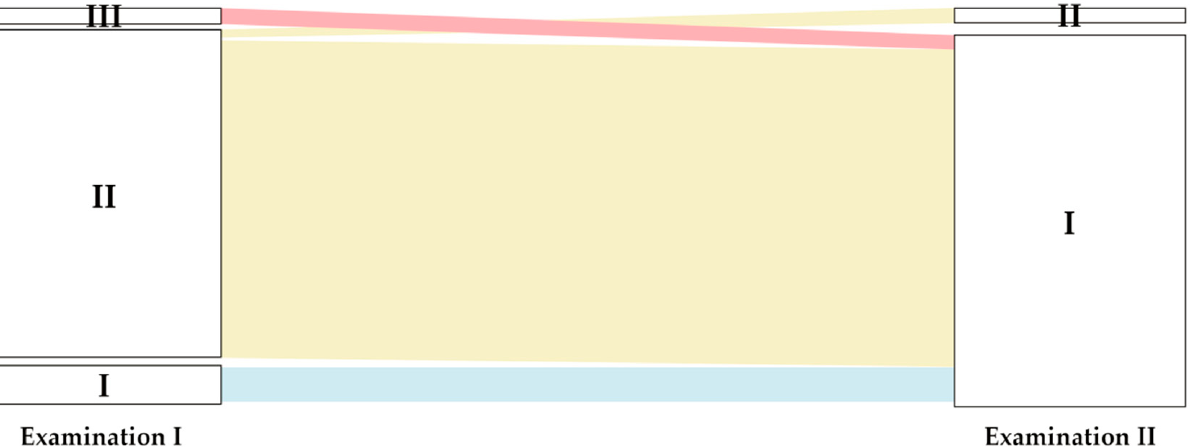
Figure 4. Change in the position of the lower lip frenal attachment, I—mucosal attachment, II—gingival attachment, III—papillary attachment.